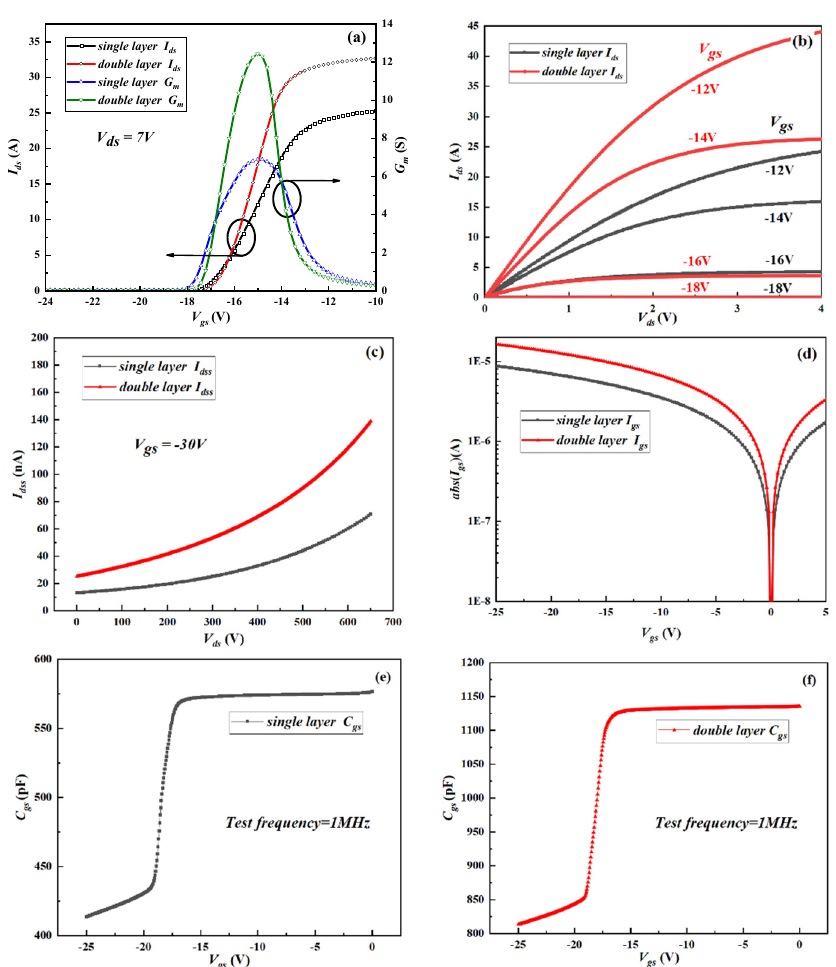
Figure 4. The comparison between the electrical properties of the single − layer and double − layer GaN MISHEMTs. ( a ) Transfer characteristics, ( b ) output characteristics, ( c ) drain − to − source leakage current, ( d ) gate − to − source leakage current, ( e , f ) gate capacitor. (Data was measured by the semiconductor device analyzer (Agilent B1500 and B1505 are produced by Keysight, Santa Rosa, CA, USA).